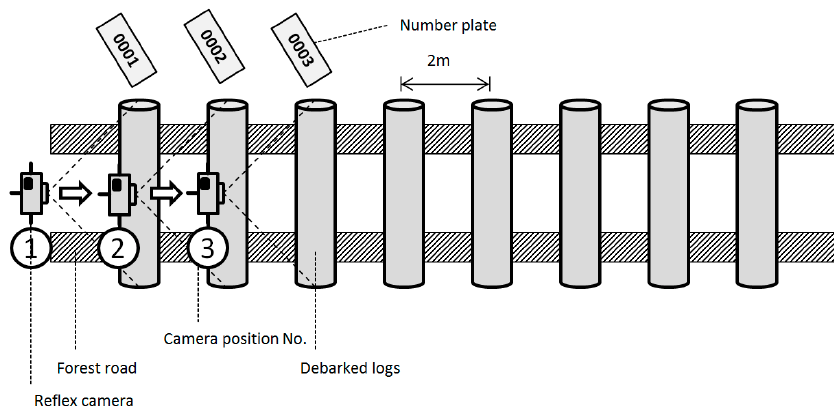
Figure 5. Schematic illustration showing the parallel positioning of processed logs placed on a forest road ready for image acquisition.